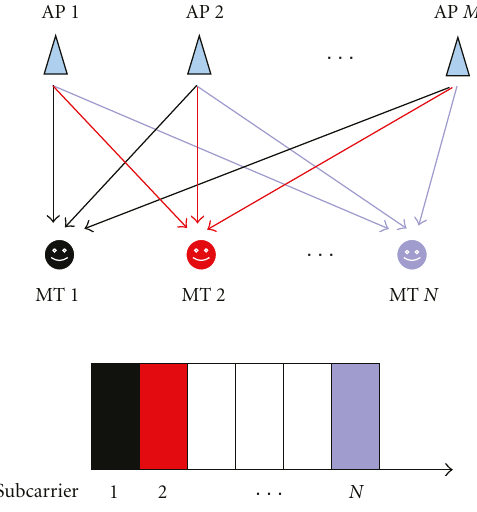
Figure 2: The multiuser OFDM